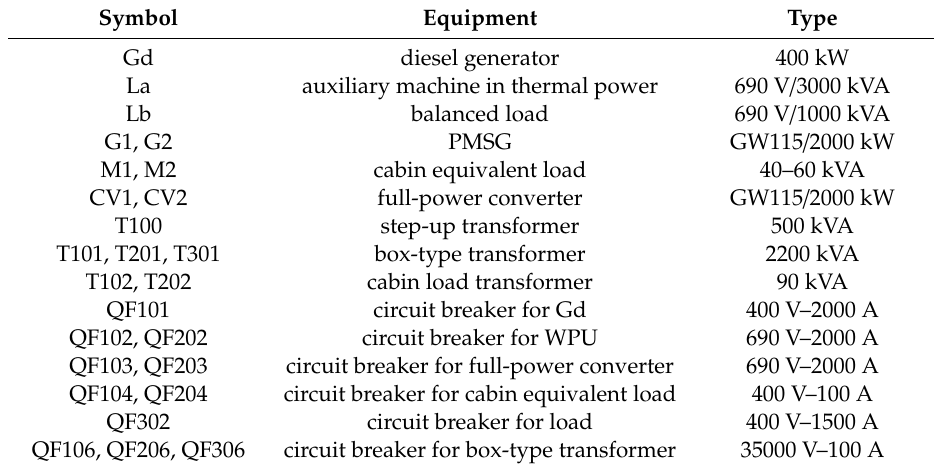
Figure 3. Field test system diagram for black start. Table 1. Equipment list for the black-start test.